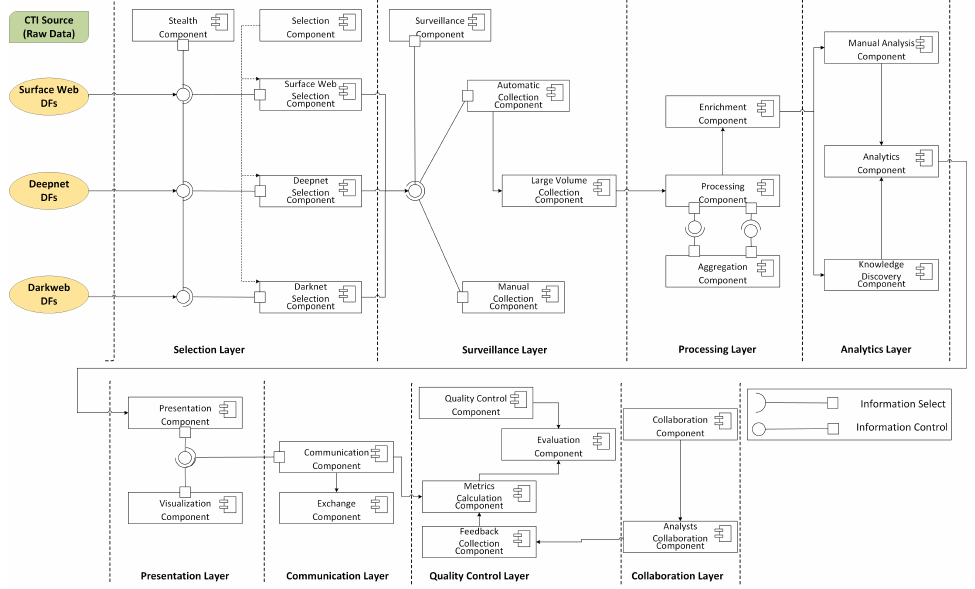
Figure 9. SECDFAN Reference